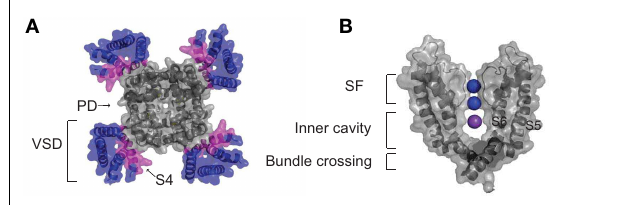
FIGURE 1 | Overview of Kv channel structure. (A) A top down view of the Kv1.2 open state channel tetramer (PDB: 2A79) with the voltage-sensing domains (S1–S4) in color.The charge carrying S4 segment of the voltage sensor domain is highlighted magenta and the pore domain S5–S6 segments are gray. (B) Side view of two pore forming subunits of the Kv1.2 illustrating the selectivity filter containing two K + ions of a possible four in positions 2 and 4 shown in blue and a K + ion residing in the intracellular cavity in